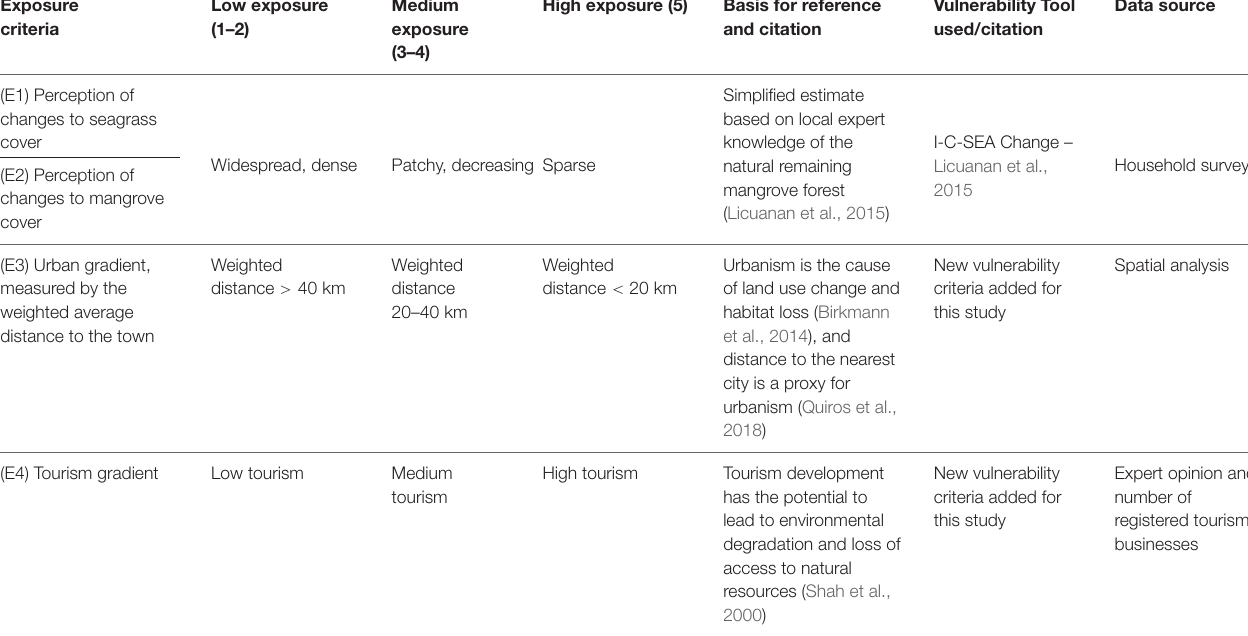
TABLE 1 | Exposure criteria. Exposure